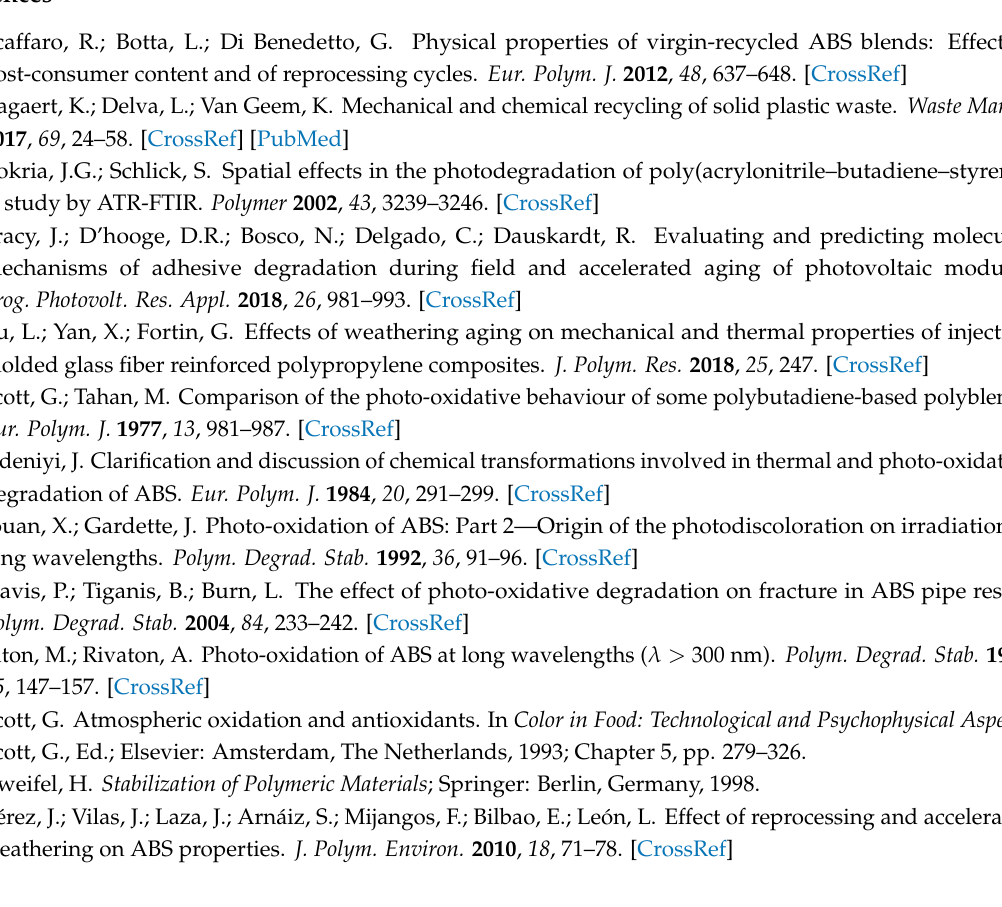
Figure S1: FTIR spectra of the sample type ABS 0. (a) Injection molded; (b) and (c) 1st aging, UV exposed side and unexposed side, respectively; (d) and (e) 2nd aging, UV exposed side and unexposed side, respectively; (f) and (g) 3rd aging, UV exposed side and unexposed side, respectively. ‘r’ means repeated analysis; Figure S2: FTIR spectra of the sample type ABS 1. (a) Injection molded; (b) and (c) 1st aging, UV exposed side and unexposed side, respectively; (d) and (e) 2nd aging, UV exposed side and unexposed side, respectively; (f) and (g) 3rd aging, UV exposed side and unexposed side, respectively. ‘r’ means repeated analysis; Figure S3: FTIR spectra of the sample type ABS 2. (a) Injection molded; (b) and (c) 1st aging, UV exposed side and unexposed side, respectively; (d) and (e) 2nd aging, UV exposed side and unexposed side, respectively; (f) and (g) 3rd aging, UV exposed side and unexposed side, respectively. ‘r’ means repeated analysis; Figure S4: SEM images of the sample type ABS 0. (a) Injection molded (unaged); (b) and (c) 1st aging, UV exposed side and unexposed side, respectively; (d) and (e) 2nd aging, UV exposed side and unexposed side, respectively; (f) and (g) 3rd aging, UV exposed side and unexposed side, respectively; Figure S5: SEM images of the sample type ABS 1. (a) Injection molded (unaged); (b) and (c) 1st aging, UV exposed side and unexposed side, respectively; (d) and (e) 2nd aging, UV exposed side and unexposed side, respectively; (f) and (g) 3rd aging, UV exposed side and unexposed side, respectively; Figure S6: SEM images of the sample type ABS 2. (a) Injection molded (unaged); (b) and (c) 1st aging, UV exposed side and unexposed side, respectively; (d) and (e) 2nd aging, UV exposed side and unexposed side, respectively; (f) and (g) 3rd aging, UV exposed side and unexposed side, respectively; Figure S7: Thermal oxidative resistance of the samples. (a) Heat flux curves of the sample type ABS 0; (b) Heat flux curves of the sample type ABS 1; (c) Heat flux curves of the sample type ABS